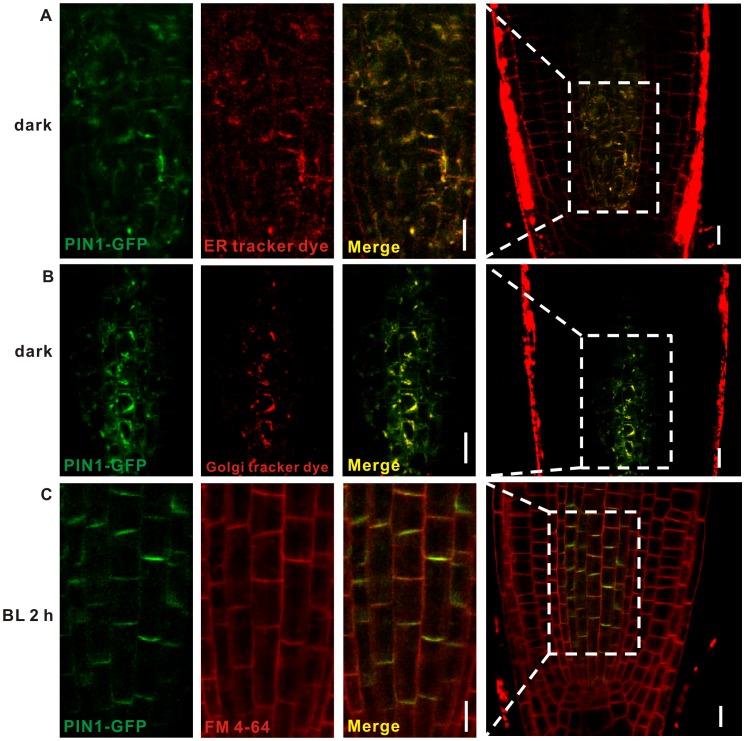
Subcellular localization of PIN1 in the roots of plants grown in the dark or exposed to blue light.(A–B) Co-localization (yellow) of PIN1-GFP (green) with ER or Golgi tracker dye (red) in the dark. Four-day-old etiolated seedlings of the PIN1::PIN1-GFP (green) marker line were pretreated with either ER tracker dye (A) or Golgi tracker dye (B) for 30 minutes in the dark before imaging. (C) Co-localization of PIN1-GFP (green) with FM 4–64 (red) after 2 h of blue light illumination. Four-day-old etiolated seedlings of the PIN1::PIN1-GFP marker line were exposed to blue light (10 µmol m−2sec−1) for 2 h, and treated with FM 4–64 for 10 minutes before imaging. (A–C) At least twelve seedlings were imaged per line for each of three replicates. Bars = 10 µm. Panels in the left are enlargements of the boxed regions shown in the rightmost column.